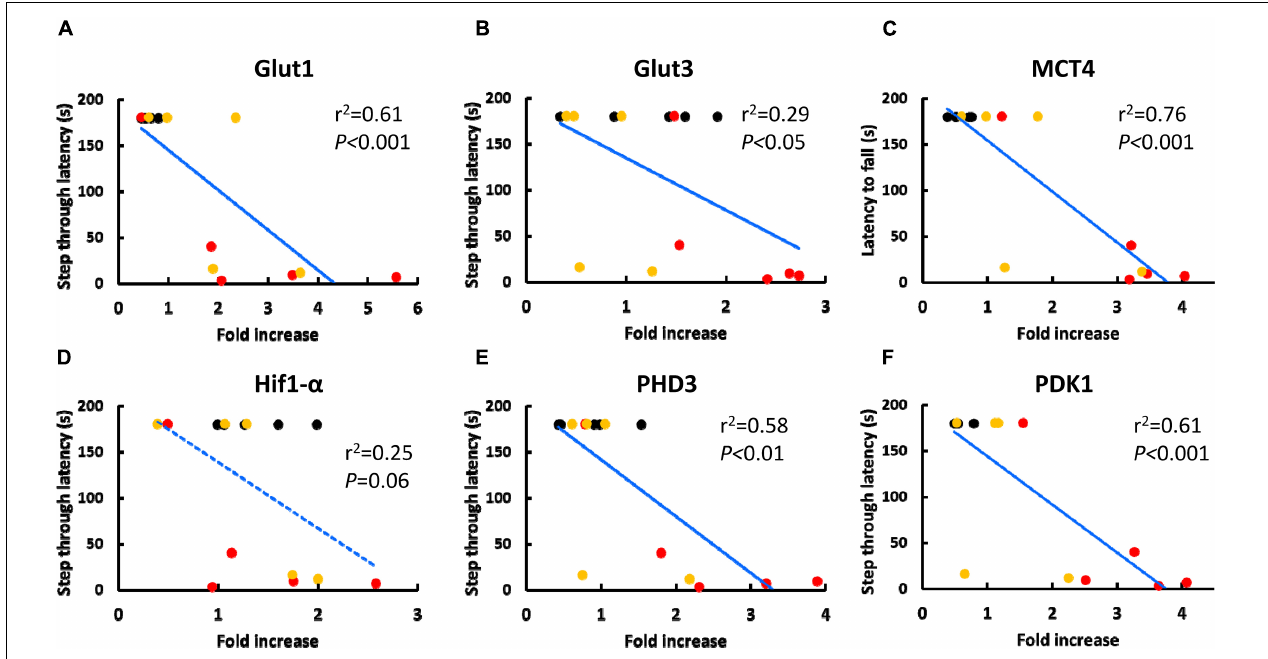
FIGURE 3 | Correlation between the score of passive avoidance test and RNA transcription of metabolism related genes in circulating WBC. (A-F) Correlation between increased in RNA transcription of Glut1 (A) , Glut3 (B) , MCT4 (C) , Hif1- α (D) , PHD3 (E) and PDK1 (F) and shorting of step through latency in passive avoidance test. Black, red or yellow dots indicate young mice, aged mice with PBS injection or aged mice with BM-MNC transplantation, respectively. Blue solid or dashed line indicate statistically highly ( p < 0.05 and | r| > 0.7) or moderately ( p < 0.05 and | r| > 0.4) correlating, respectively, by linear regression analysis ( N = 15).